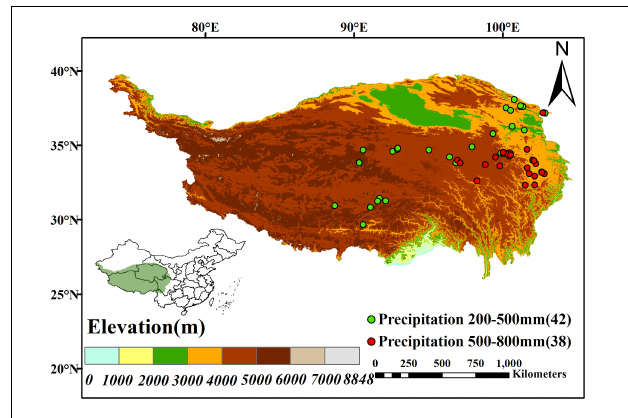
FIGURE 1 | Distribution map of the study site for publications on the Qinghai-Tibet Pl ateau (QTP) of China. Green points represent sites with 200–500 mm mean annual precipitation (MAP) (42 sites), and red points represent sites with 500–800 mm MAP (38 sites).